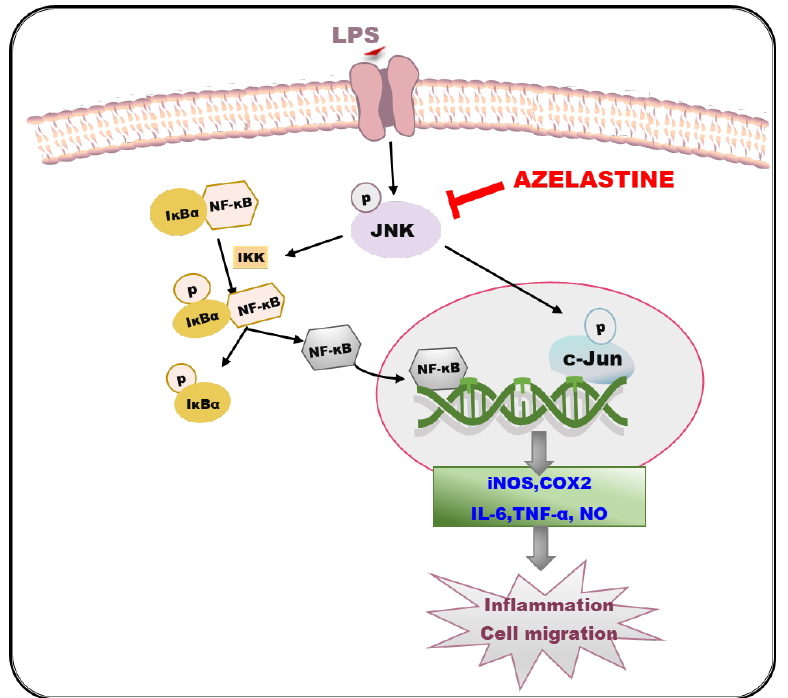
Figure 8. Schematic diagram illustrating the cellular mechanisms involved in the anti-inflammatory and anti-migratory effects of Aze in LPS-treated BV2 cells. IKK, IκB kinase; IκBα, inhibitory kappa Bα; NF-κB, nuclear factor-kappa B; iNOS, inducible nitric oxide synthase; COX2, cyclooxygenase-2; IL-6, interleukin-6, TNF-α, tumor necrosis factor-α; NO, nitric oxide.